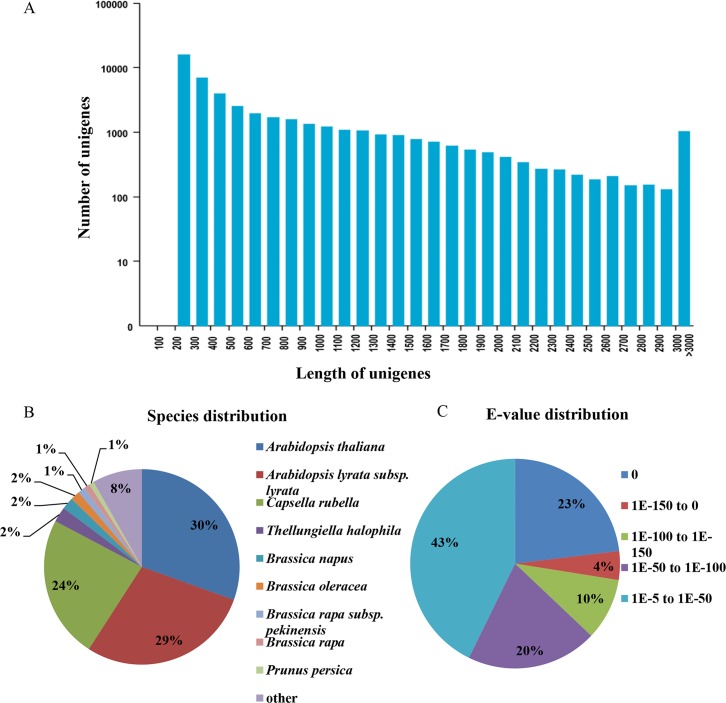
Unigenes functional annotation results.(A) Distribution of unigenes in length. (B) Top species distribution for BLASTx matches for B. napus unigenes using the following order of priority: NR and Swiss-Prot. (C) E-value distribution of top BLASTx hits for each unigene.